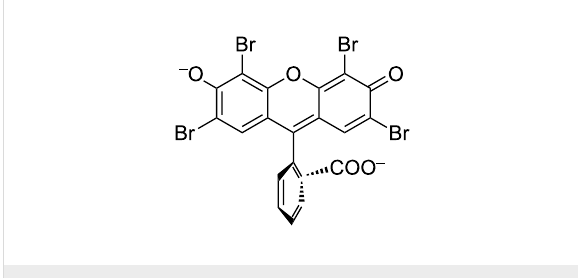
Figure 3: Chemical structure of EY.